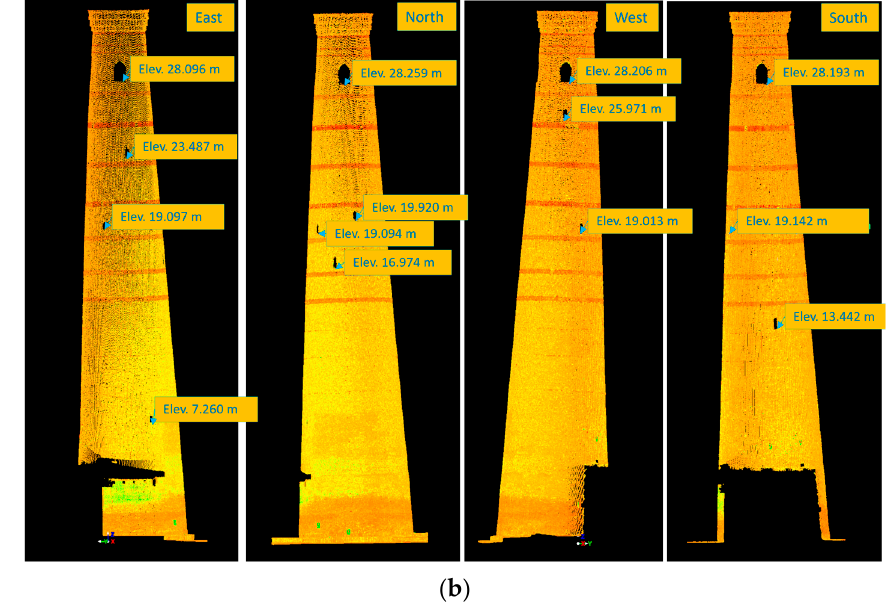
Figure 5. Juma minaret: ( a ) point cloud (Matlab) [26]; ( b ) window elevations from the east, north, west, and south sides (Cyclone).